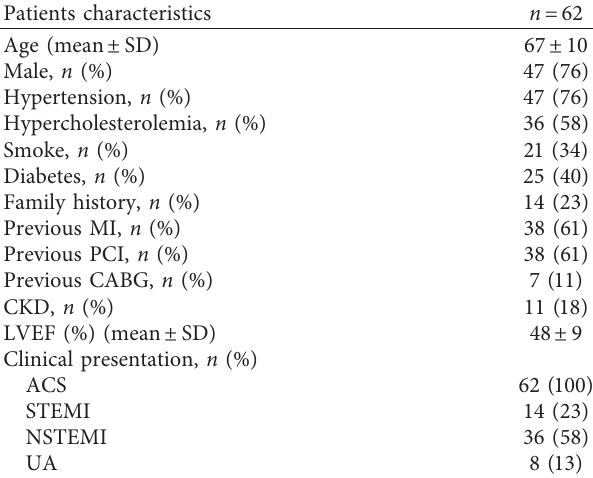
Table 1: Patients characteristics.